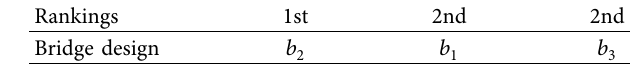
Table 8: Composition of B under the rule ⊞ .